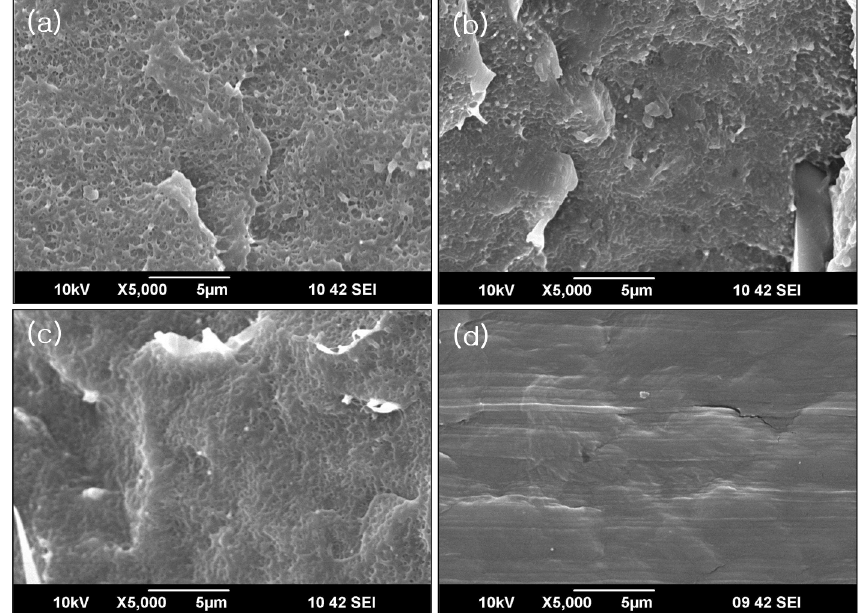
Figure 4. Scanning electron microscope (SEM) micrographs of PU (1